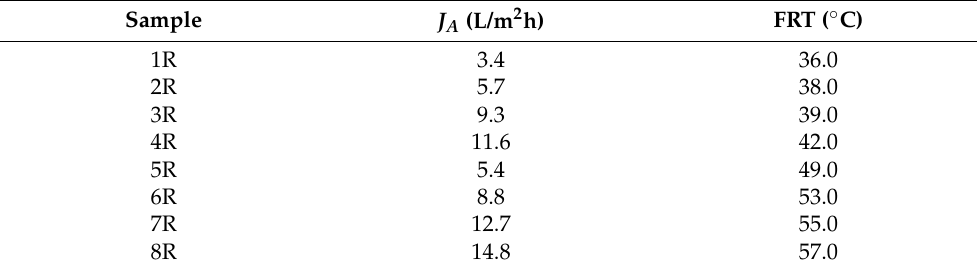
Table 1. Average permeate flux J A (L/m 2 h) and final retentate temperature (FRT) of RO retentates obtained by concentration of conventional and ecological red wine by reverse